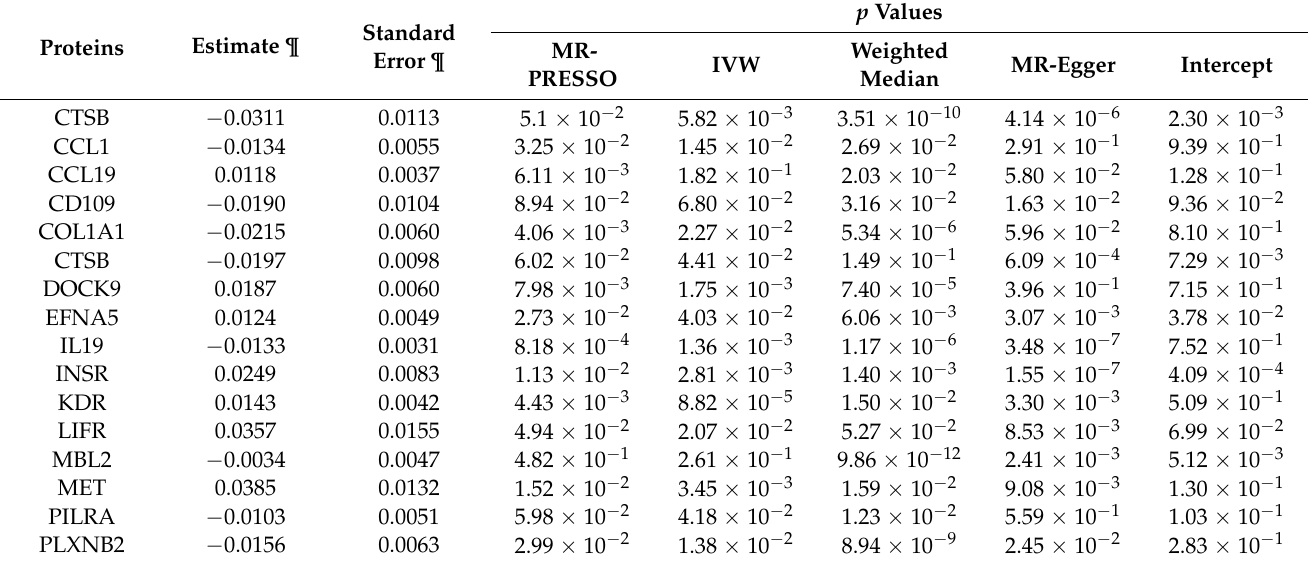
Table 2. Association between circulating protein levels and